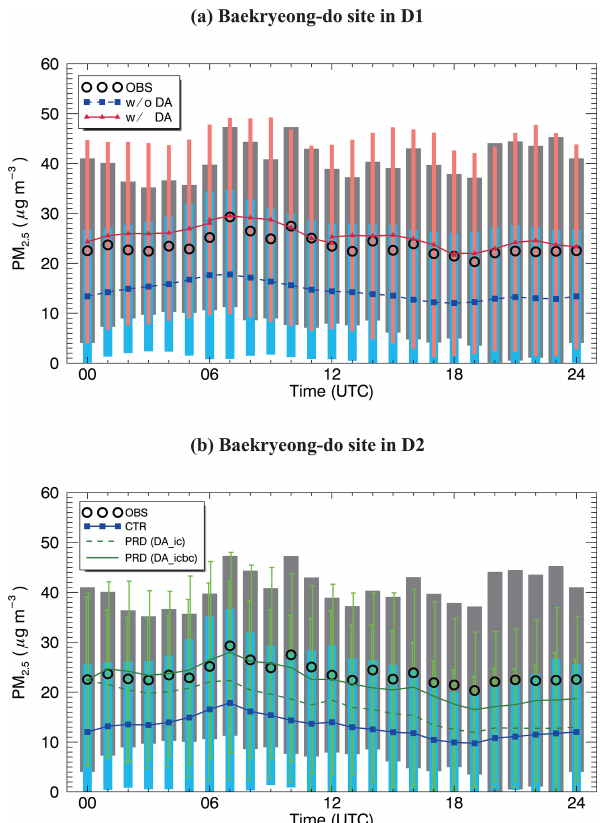
Figure 7. Averaged diurnal variations of PM 2 . 5 aggregated at the Baekryeong-do site from the results obtained in (a) D1 and (b) D2. The line colors and symbols are the same as in Fig. 5, except for the prediction runs in D2, which are plotted by dashed and solid green lines for the DA_ic and DA_icbc experiments, respectively, in panel (b)